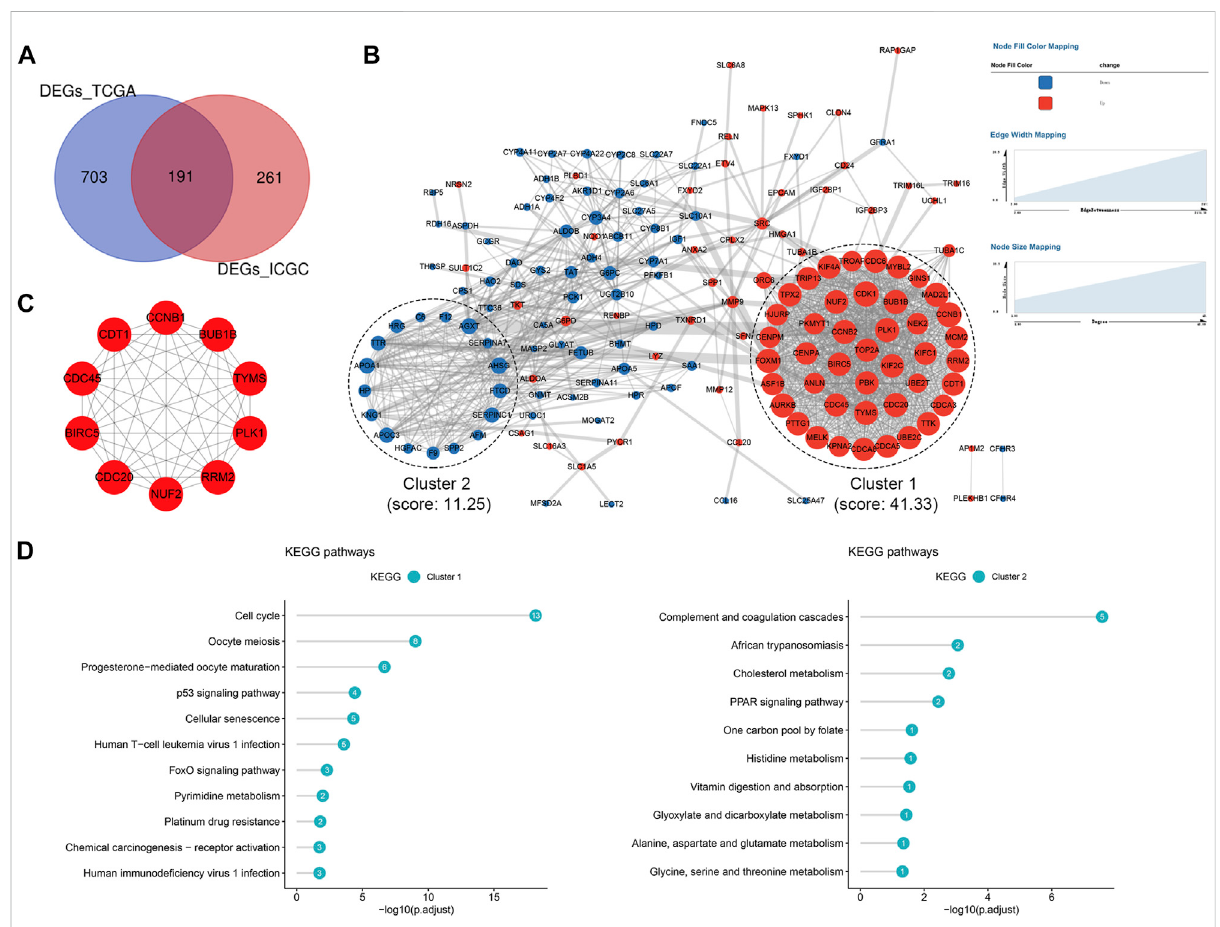
FIGURE 8 Protein-protein interaction (PPI) network based on the DEGs (A) Venn diagram of DEGs between the high- and low-risk groups shared in the TCGA and ICGC cohorts (B) PPI network constructed with the common DEGs and functional modules (C) The top 10 hub genes identi fi ed based on the PPI network (D) KEGG pathway enrichment analysis of module one and module 2. DEGs, differentially expressed genes; TCGA, The Cancer Genome Atlas; ICGC, International Cancer Genome